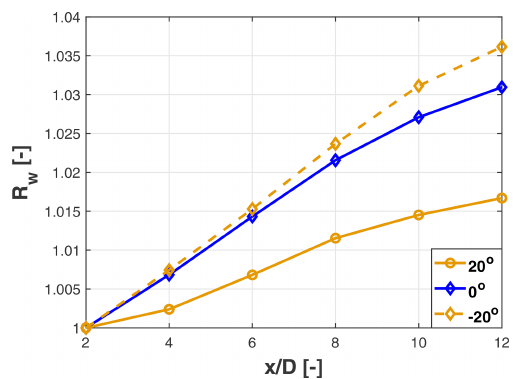
Figure 7. Wake recovery ratio R w for 0 ◦ (untilted), 20 ◦ (wake-up), and − 20 ◦ (wake-down) rotor tilt